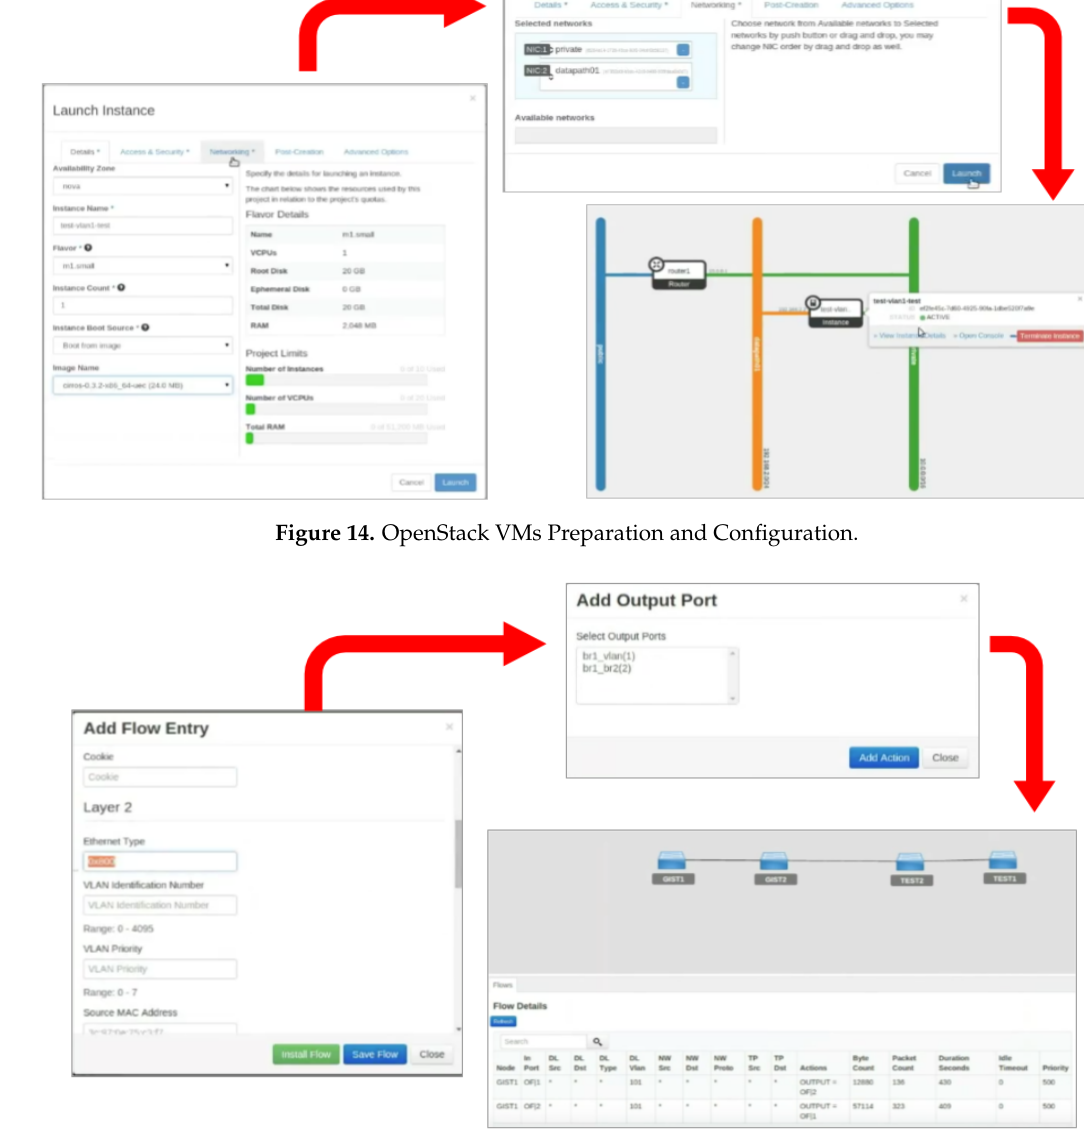
Figure 15. Flow Configuration in OpenDaylight